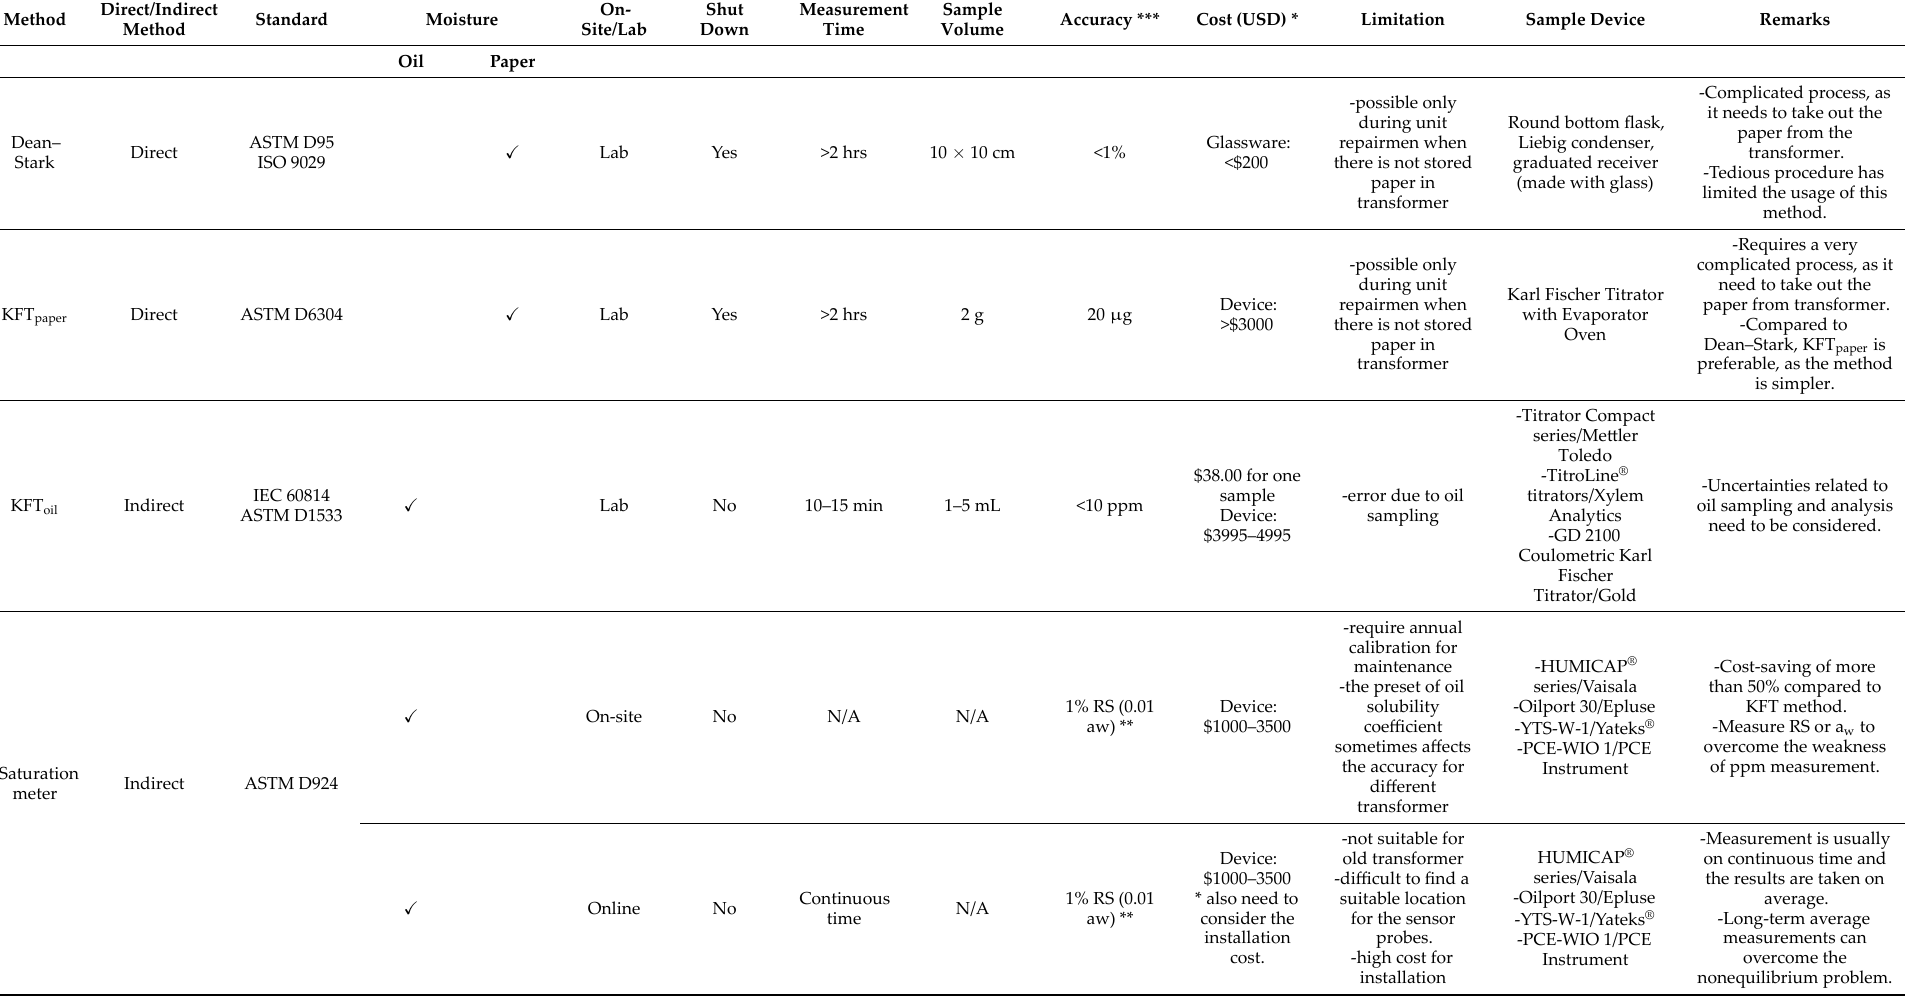
Table 10. Summary of methods to determine WCO and WCP in the